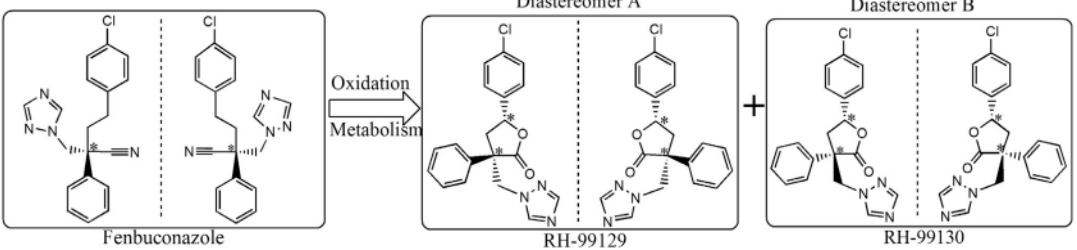
Figure 2. Chemical structure of fenbuconazol enantiomers and its metabolite diastereoisomers. Reproduced with permission of Elsevier from ref. 39.